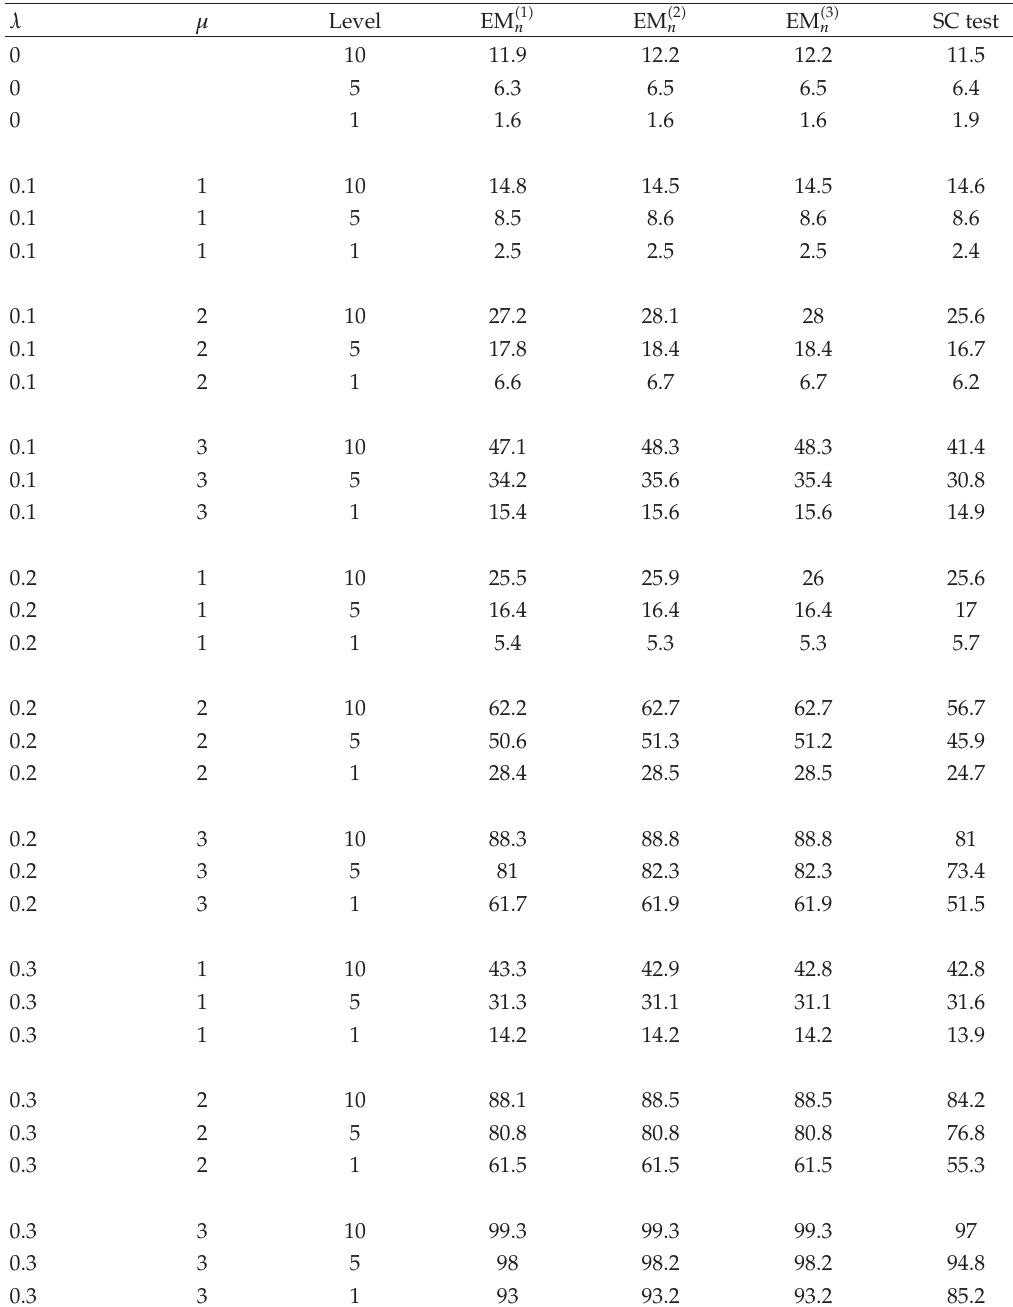
Table 1: Type I error and power comparisons (cid:2) % (cid:3) of the EM test and the score test (cid:2) SC test (cid:3) for log-normal model: n 0 (cid:5) n 1 (cid:5)